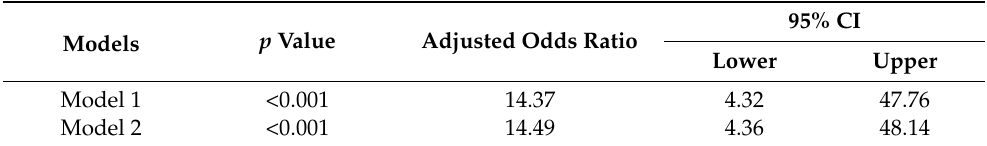
Table 11. Likelihood of intraventricular hemorrhage grades I–II among infants delivered between 30 and 34 weeks in the control group on multivariate